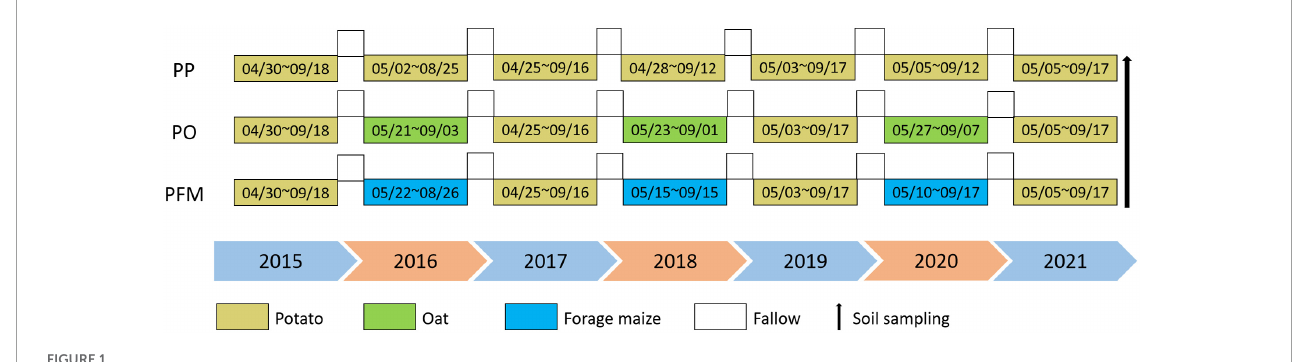
FIGURE1 Schematic diagram of three experimental planting